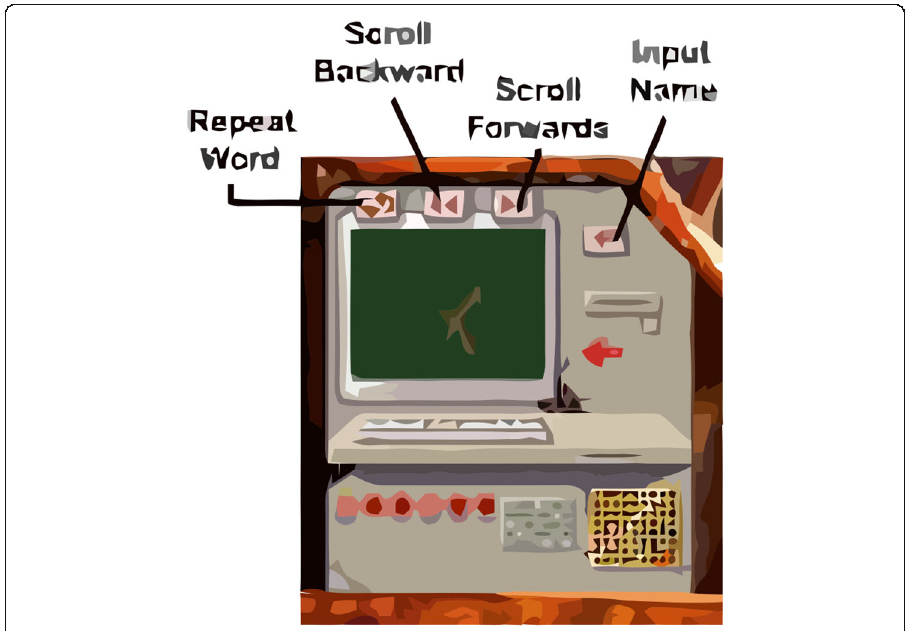
Fig. 2 The computer in the Creatures video